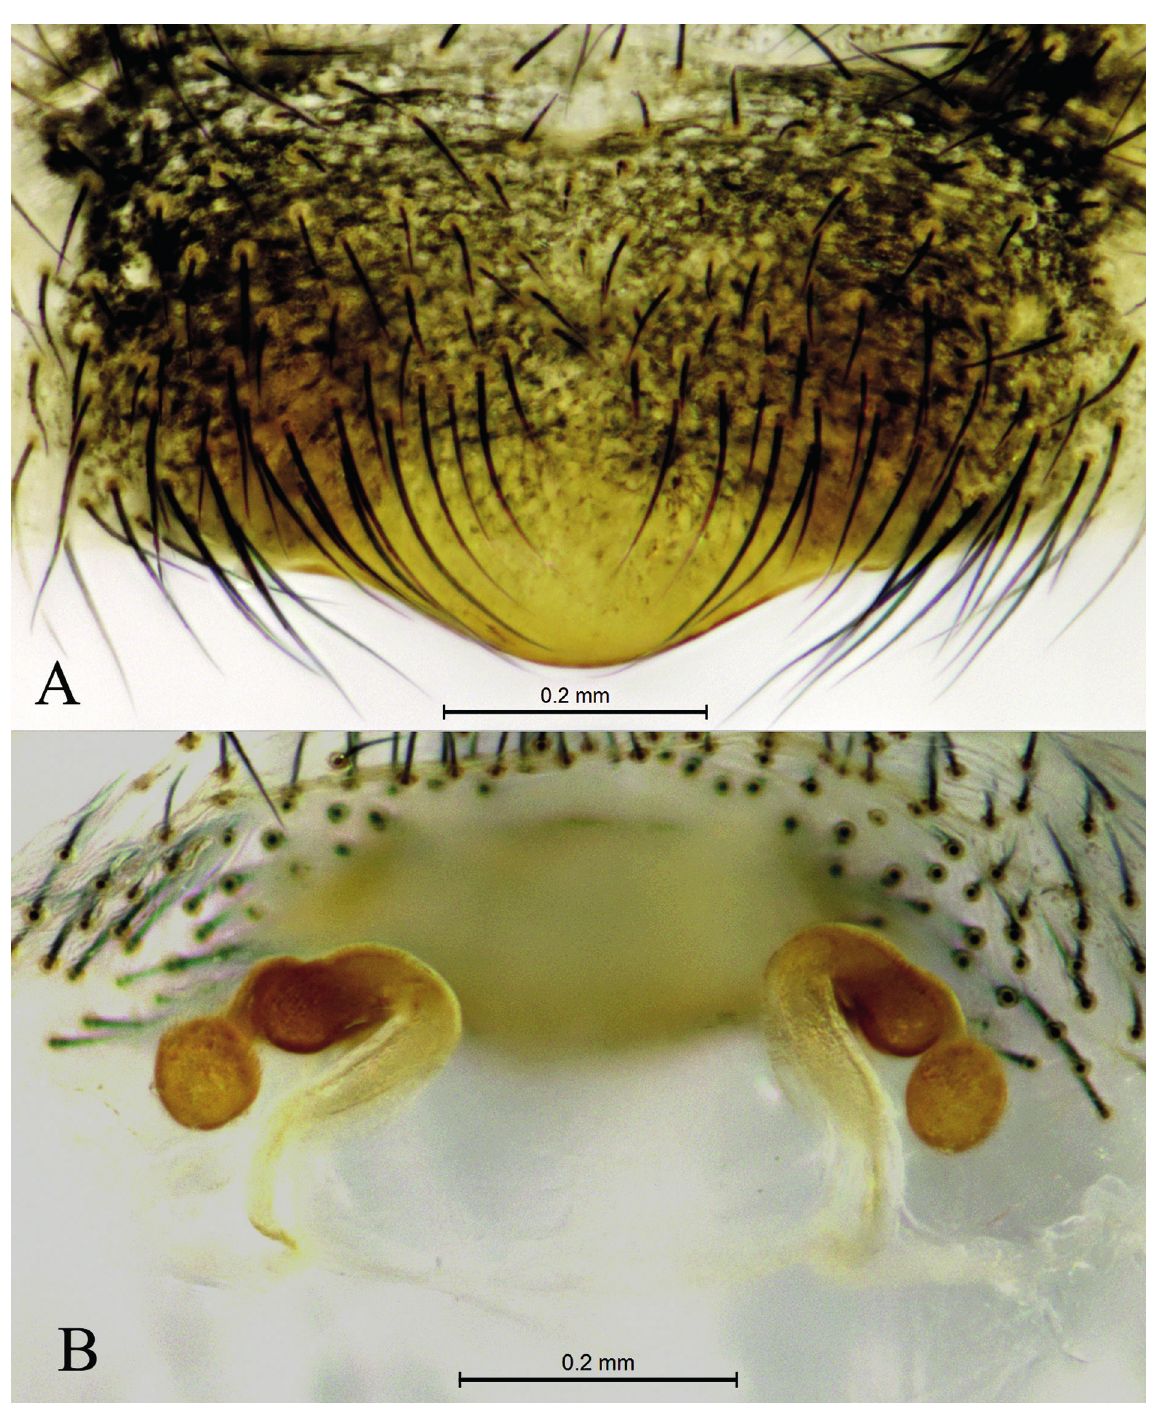
Fig. 7. Meta cona sp. nov., ♀, paratype (SWUC-T-TEg-03-02). A . Epigyne, ventral view. B . Vulva, dorsal